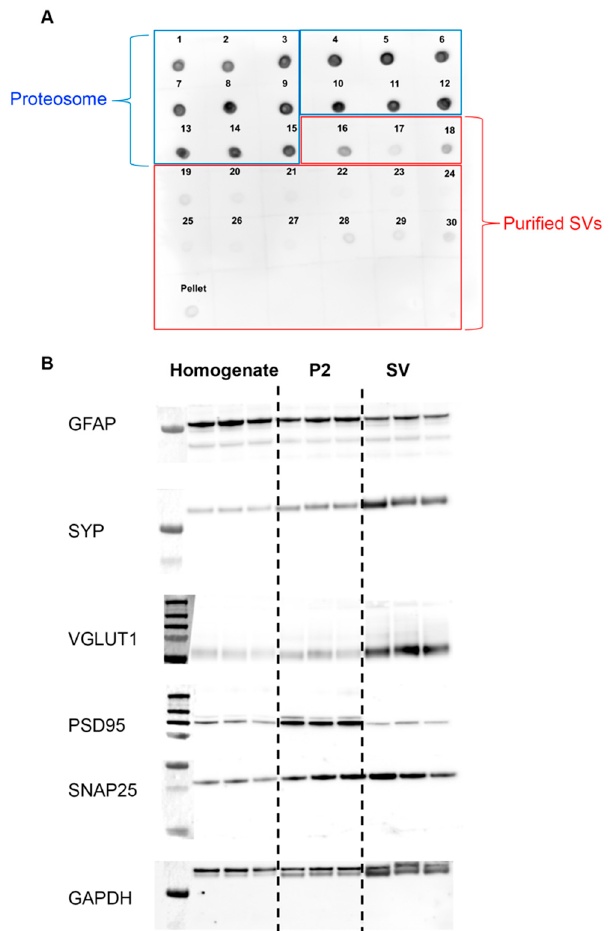
Figure 1. SVs purity validation. ( A ) Dot blot analysis of SVs from P14 saline rats shows purified SVs within the 16–30 fraction range. ( B ) Western blot analysis of SVs from P14 saline rats shows the expression of positive SV markers (VGLUT1, SYP, SNAP25) and negative markers (GFAP, PSD95). Further, we validated the purity of our isolated SVs through Western blot analysis.